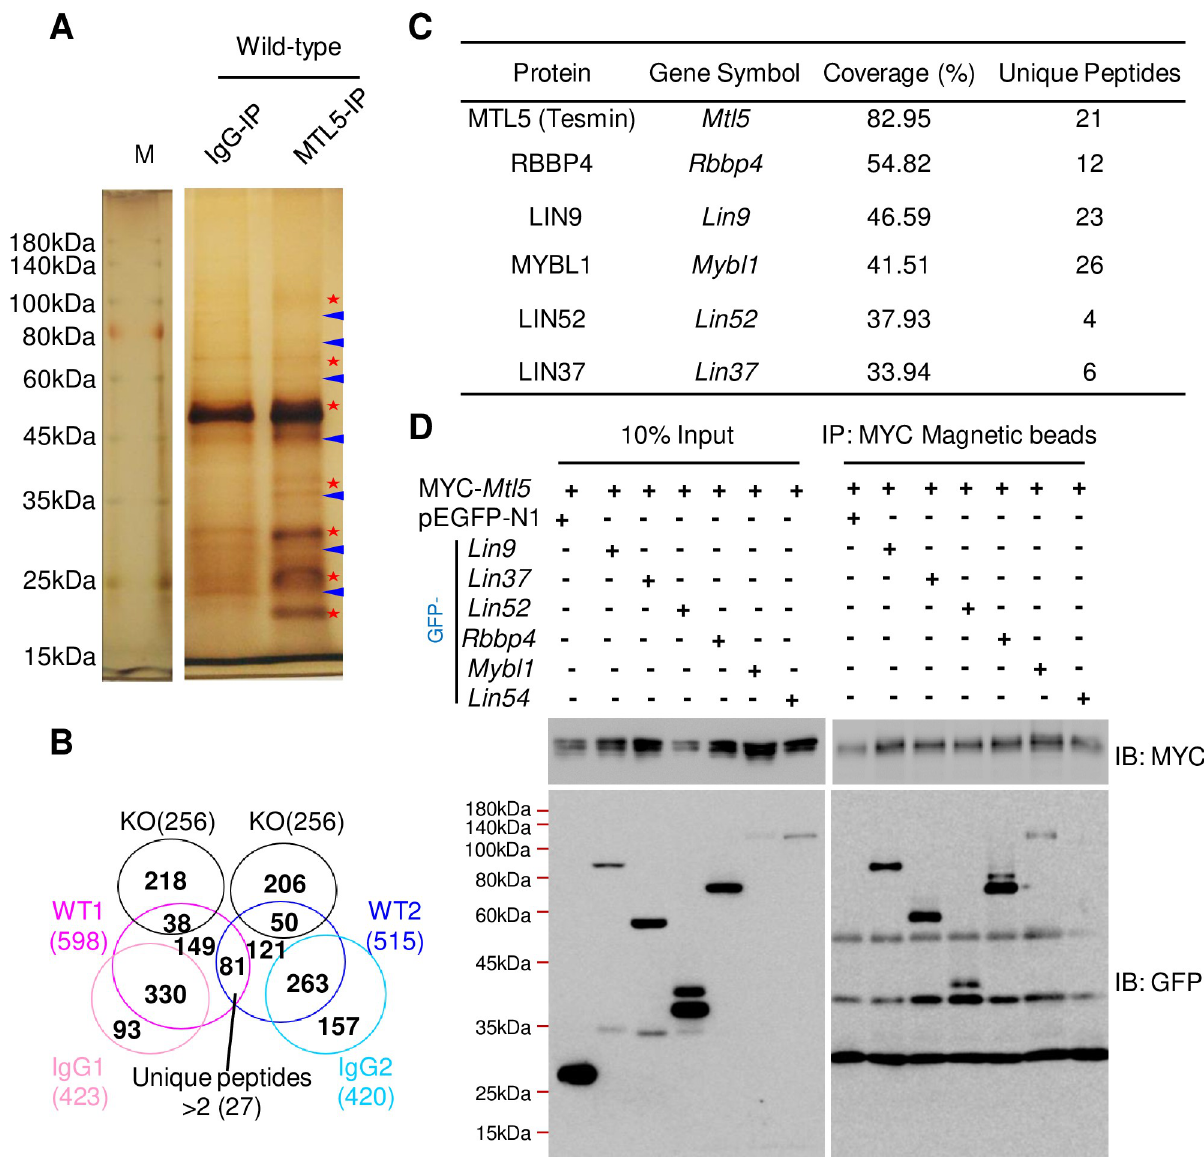
Fig 2. MTL5 interacts with most components of the MuvB core complex. (A) Silver staining of the samples immunoprecipitated with MTL5 antibody (epitope from 221 aa to 475 aa) from pachytene and diplotene spermatocytes of 10-week-old wild-type mouse after SDS-PAGE. Rabbit IgG served as a negative control. Red stars mark the different bands between IgG and MTL5 antibody group. Blue arrowheads indicate the unspecific bands. M indicates protein marker. (B) Identification of proteins interacting with MTL5 by IP-MS followed by subtractive analysis of three proteomic data sets with two biological repetitions. Proteins with at least three unique peptides in wild-type groups, but absent in both IgG and knockout (KO) groups, were considered as candidate MTL5-interactive proteins. Numbers in the brackets indicate the number of proteins. (C) Rank of the top candidates, from high to low, sorted by the coverage (%). The top 6 candidates are shown. (D) Western blot detection of the interaction between MTL5 (fused with a MYC tag) and each of MuvB core complex components or MYBL1 (fused with a GFP tag) in HEK293T cells after co- immunoprecipitation with MYC-tag magnetic beads. pEGFP-N1 was served as the negative control. IP, immunoprecipitation. IB, immunoblotting. encoding GFP- Lin9 or GFP- Rbbp4 , respectively (for the controls, GFP- Lin37 , GFP- Lin52 , or GFP- Mybl1 encoded plasmids were also co-transfected with MYC- Mtl5 constructs respec- tively). MTL5 was diffusely localized in the cytoplasm of HEK293T cells when transfected with MYC- Mtl5 alone or with the pEGFP-N1 vector (Fig 3A and 3B). As expected, the cytoplasmic